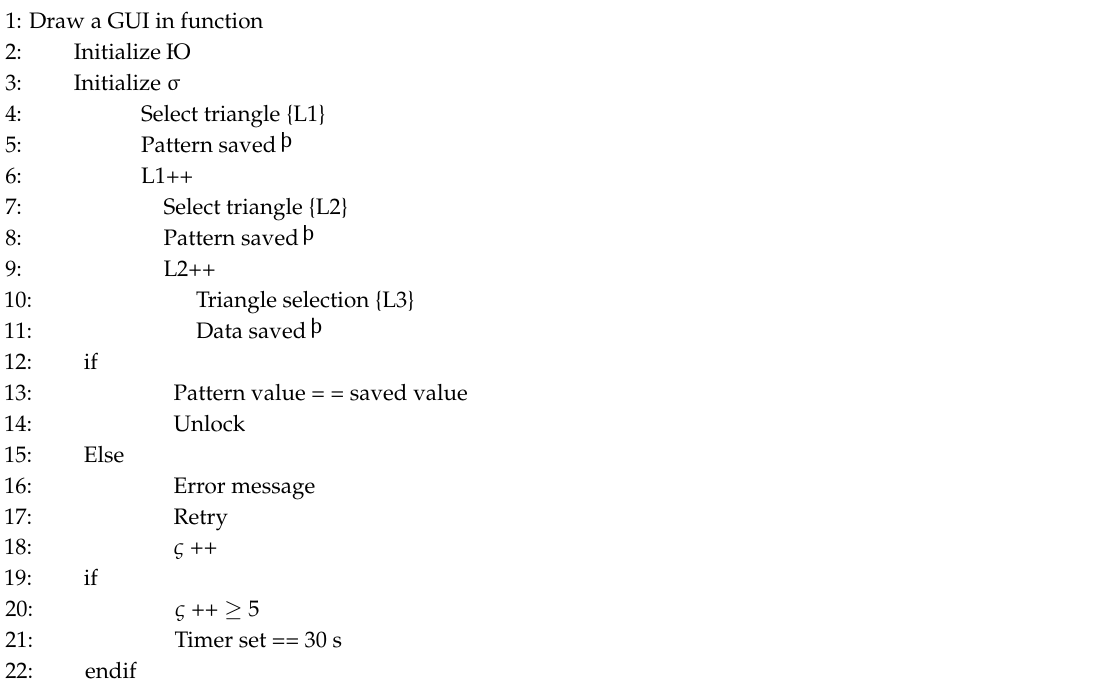
Figure 3 . Sequence diagram for password registration and verification. Algorithm 2. Authentication Phase of FBAT Table 2 . Notations.